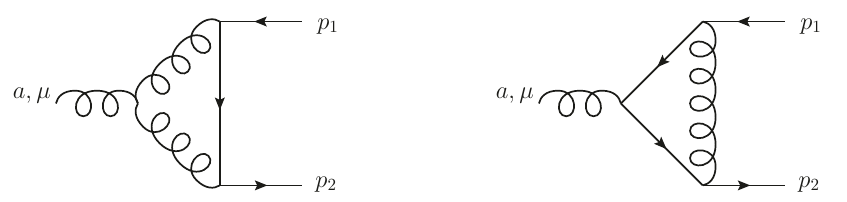
Figure 1 . Triangle Feynman diagrams used in the computation for the non-supersymmetric gauge- theory